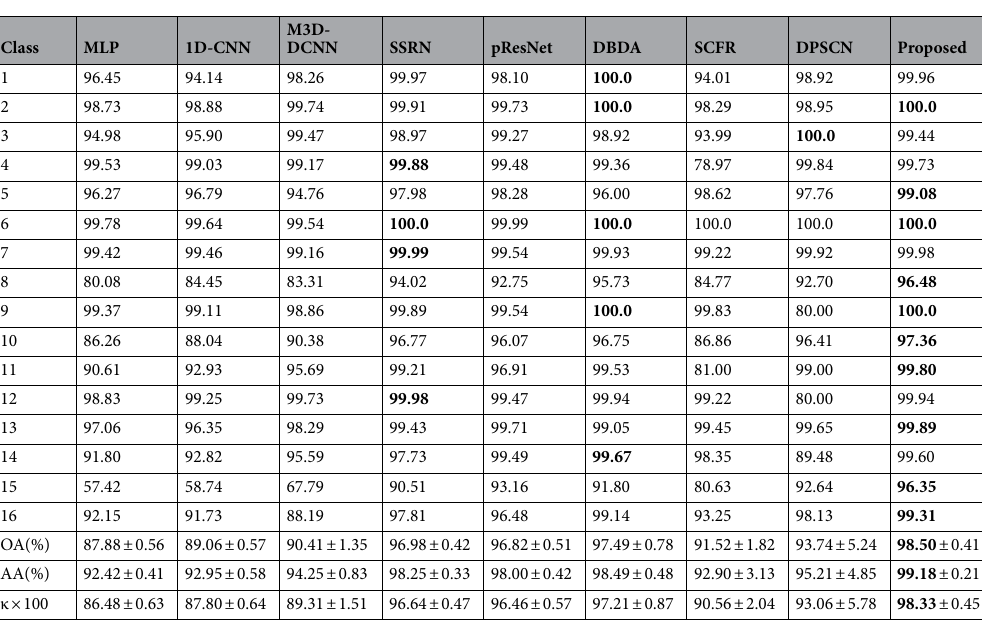
Table 6. Classification results of 1% samples of SA dataset. Significant values are in